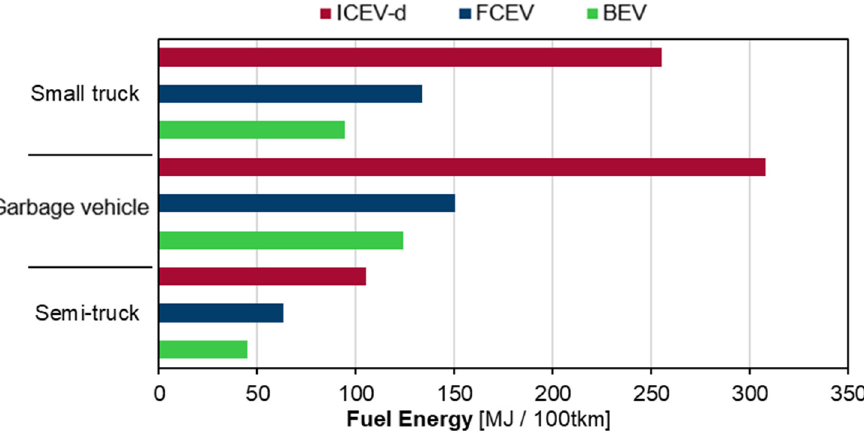
Figure 16. Fuel energy demand for a small truck (urban cargo), garbage vehicle, and semi-truck (long-haul).